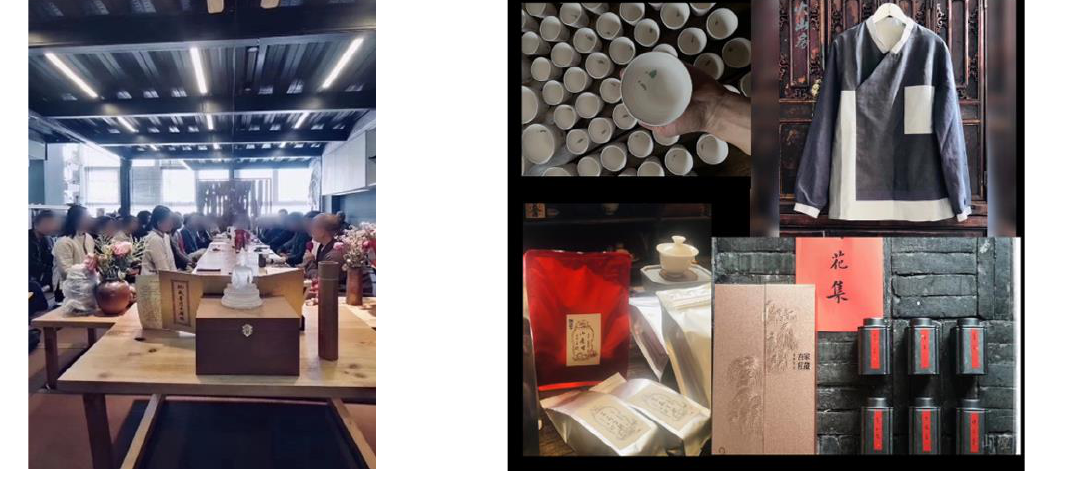
Figure 3: Other commodities sold by the group. (Photo by the